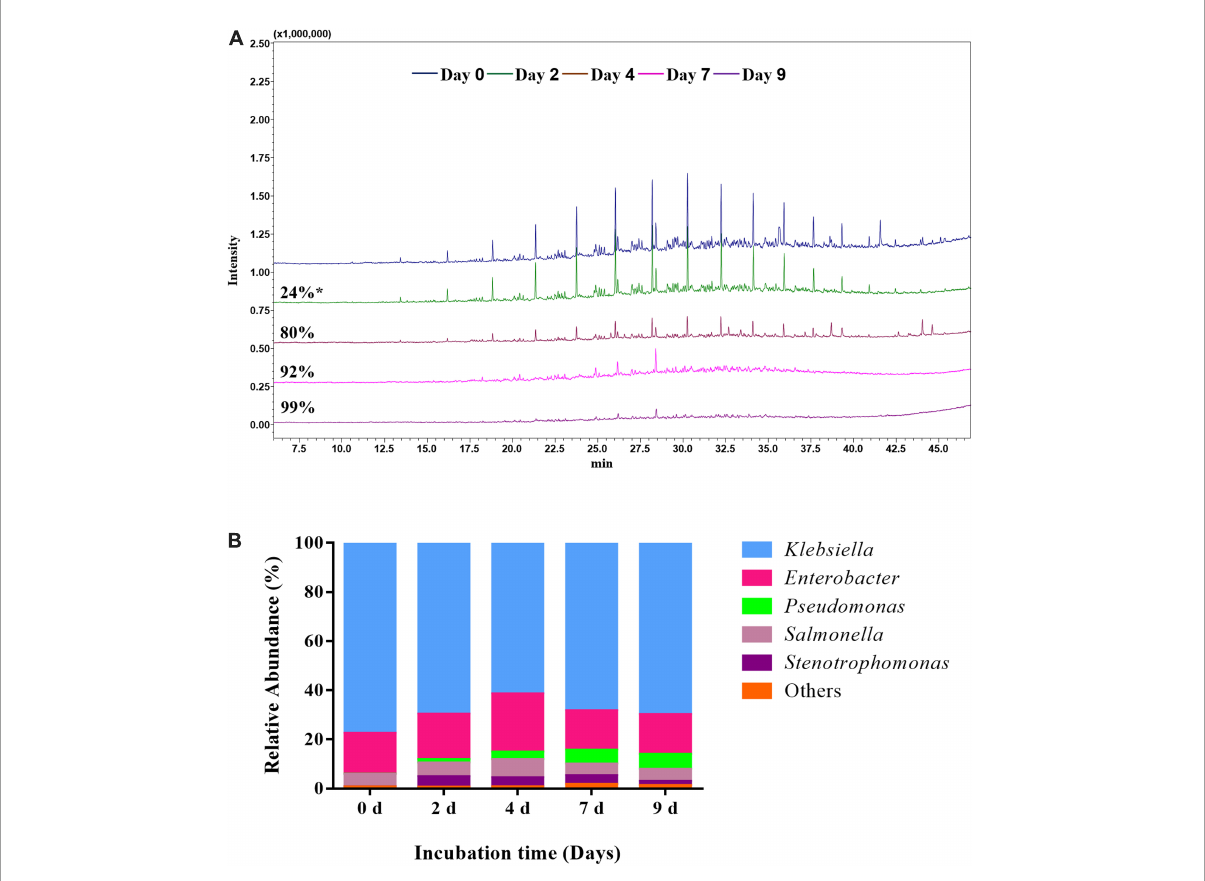
FIGURE5 Total ion chromatograms (A) showing biodegradation of oily sludge hydrocarbons by the mixed culture AK6 at different time intervals (0, 2, 4, 7, and 9 days) and the associated compositional shifts in the structure of the AK6 consortium (B) . *: Hydrocarbon degradation